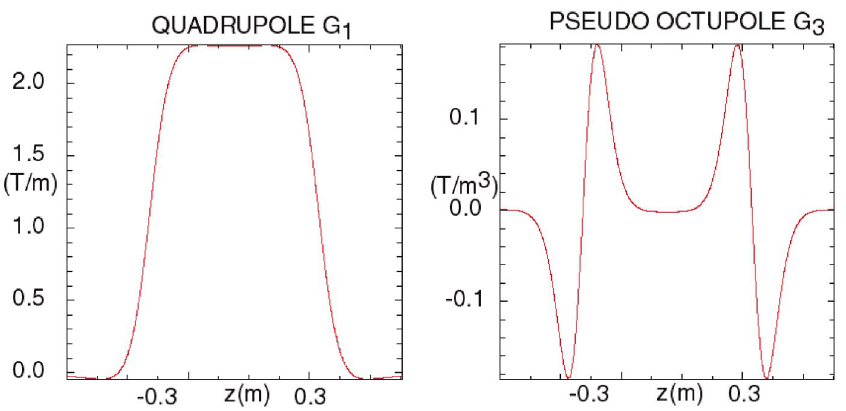
FIG. 6. (Color) Dominant (a) quadrupole and (b) pseudooctupole coefficients for the multipole decomposition (cid:9) r; (cid:15); z (cid:10) (cid:2) G (cid:9) z (cid:10) r cos (cid:9) 2 (cid:15) (cid:10) (cid:1) G (cid:9) z (cid:10) r 3 cos (cid:9) 2 (cid:15) (cid:10) (cid:1) . . . . B ? 1 3